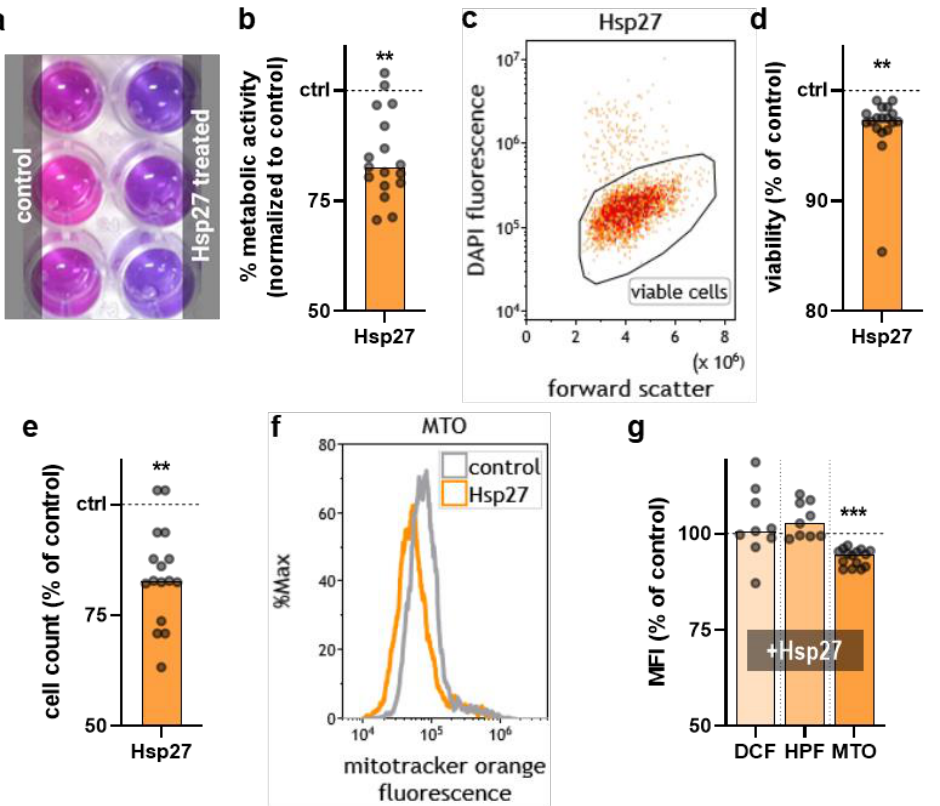
Figure 2. THP-1 metabolic activity, viability, and oxidation processes upon Hsp27 exposure. ( a ) representative photograph of the resazurin-based metabolic activity assay in the control and Hsp27-treated THP-1 cells; ( b ) normalized metabolic activity of the THP-1 cells 24 h after Hsp27 exposure; ( c ) representative flow cytometry dot plot of the Hsp27-treated THP-1 cells; ( d , e ) normalized viability ( d ) and cell counts € of the THP-1 cells 24 h after Hsp27 exposure; ( f ) representative flow cytometry overlay histograms of mitotracker orange fluorescence in the THP-1 cells in the presence or absence of extracellular Hsp27; ( g ) normalized (vehicle) mean fluorescence intensity (MFI) of DCF, APF, and MTO-stained and Hsp27-treated THP-1 cells. Statistical analysis was performed using an unpaired two-tailed t -test with p < 0.01 (**) and p < 0.001 (***).